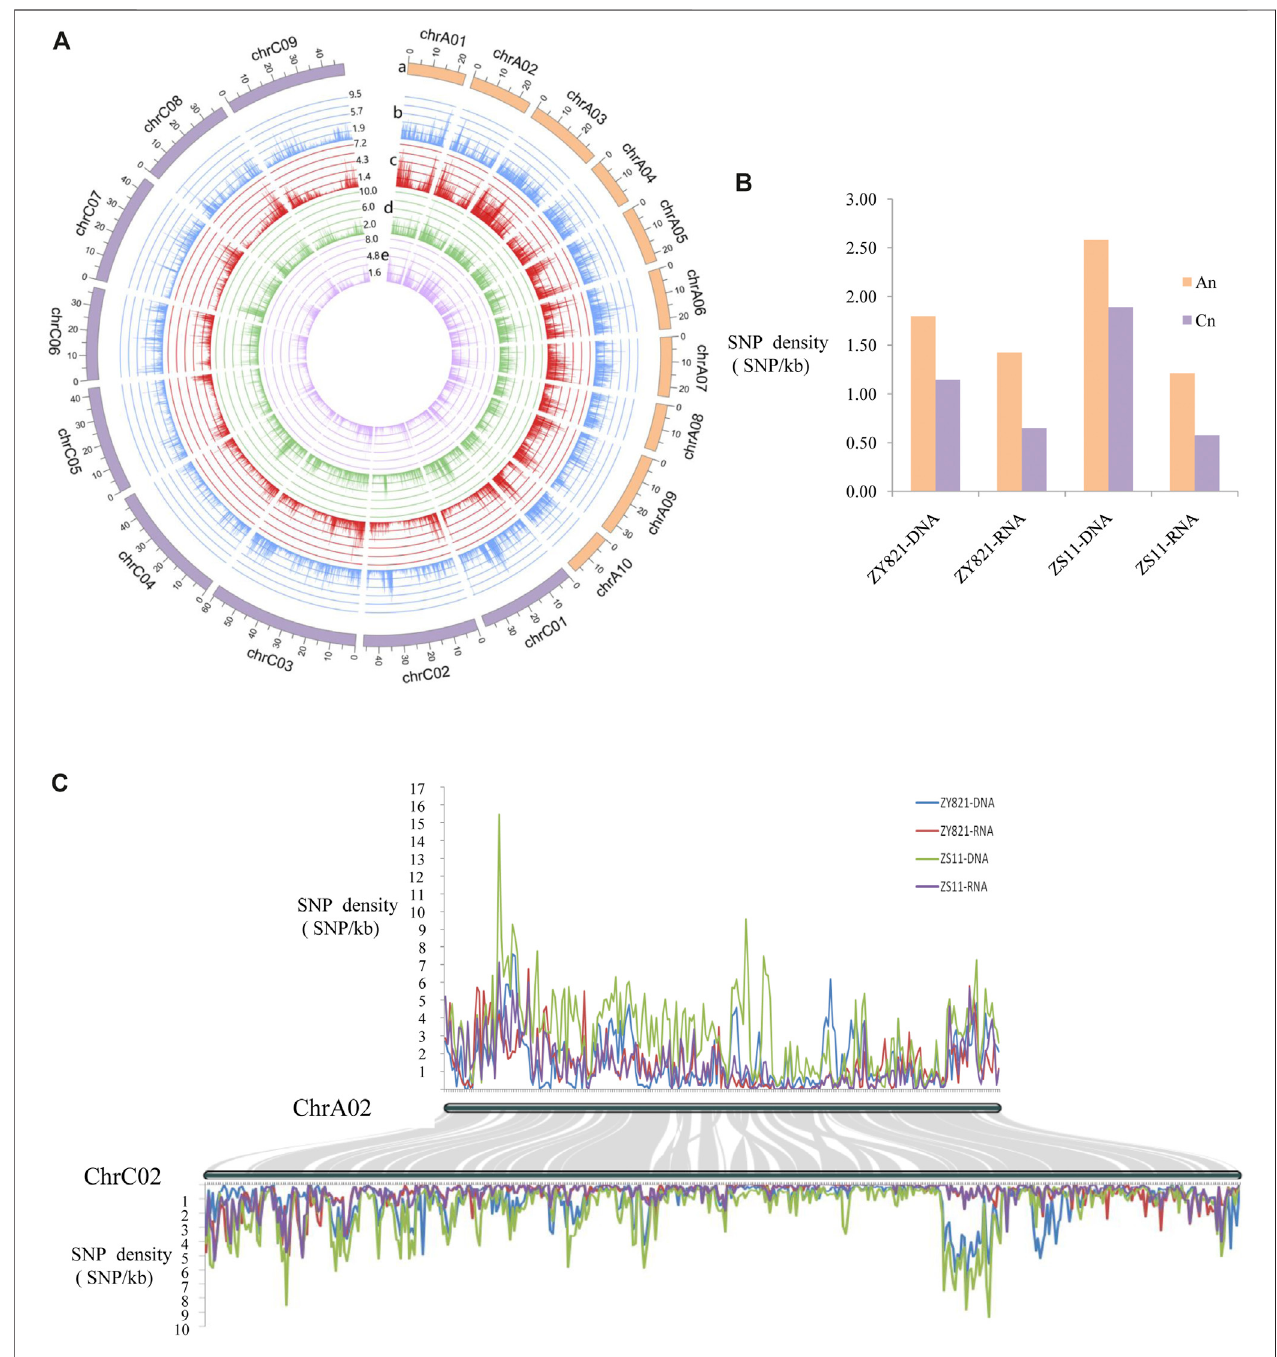
FIGURE 1 | Distribution of SNP density on DNA/RNA levels of two B. napus lines ZY821 and ZS11 (A) Density of SNPs in 19 chromosomes among four levels. a: Sizes (Mb) of 19 chromosomes in B. napus ; b – e: line graph of SNP density (y-axis, numbers of SNPs/kb) for chromosomes at ZY821 and ZS11 genomic and transcriptional levels, respectively. (B) Distribution of SNP density in two subgenomes. (C) Local comparison of SNP density in chromosomes chrA02 and chrC02. Connecting gray lines in background highlight conserved syntenic genes between chrA02 and